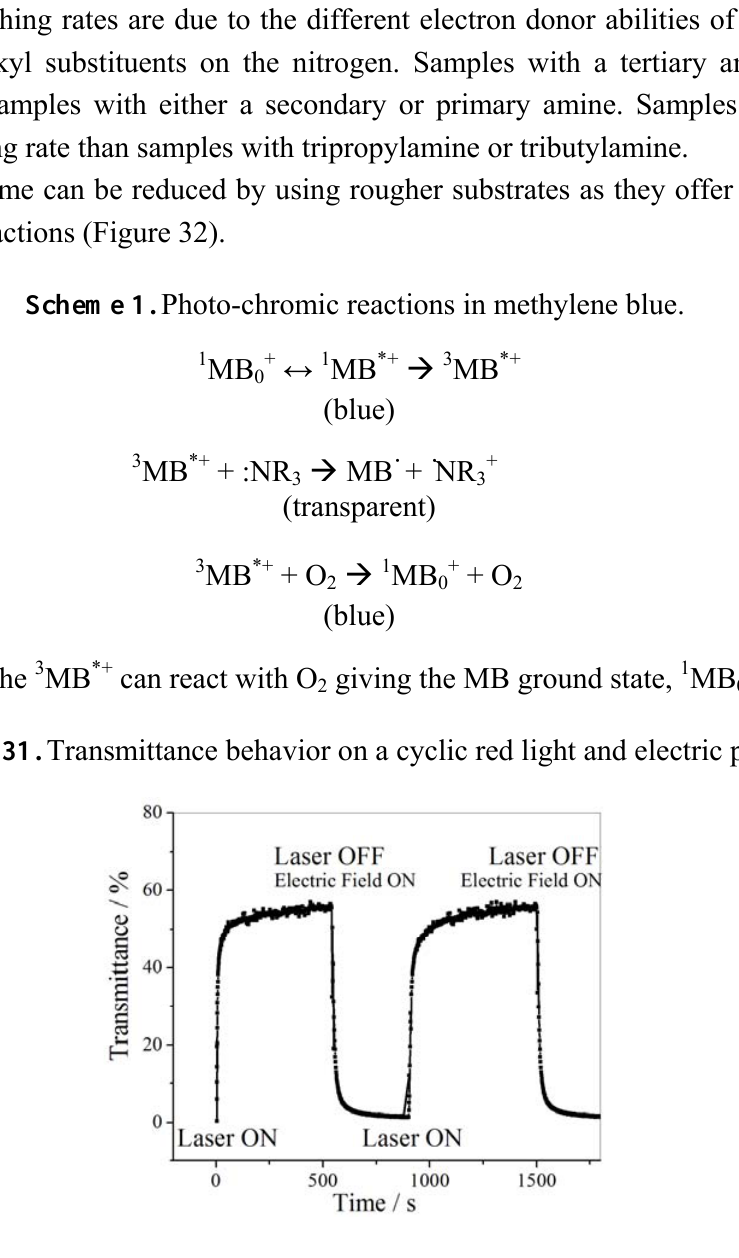
Figure 32. Coloring time as a function of substrate